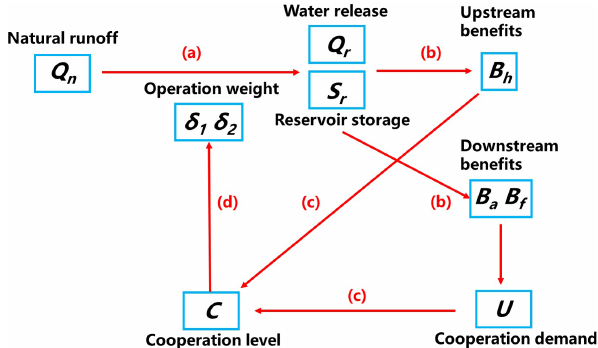
events and the cooperation dynamics and provide mechanis-